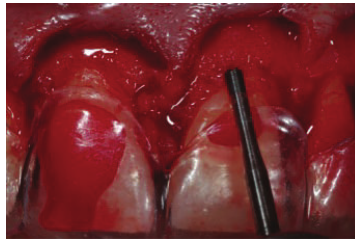
Figure 14: Installation of provisional